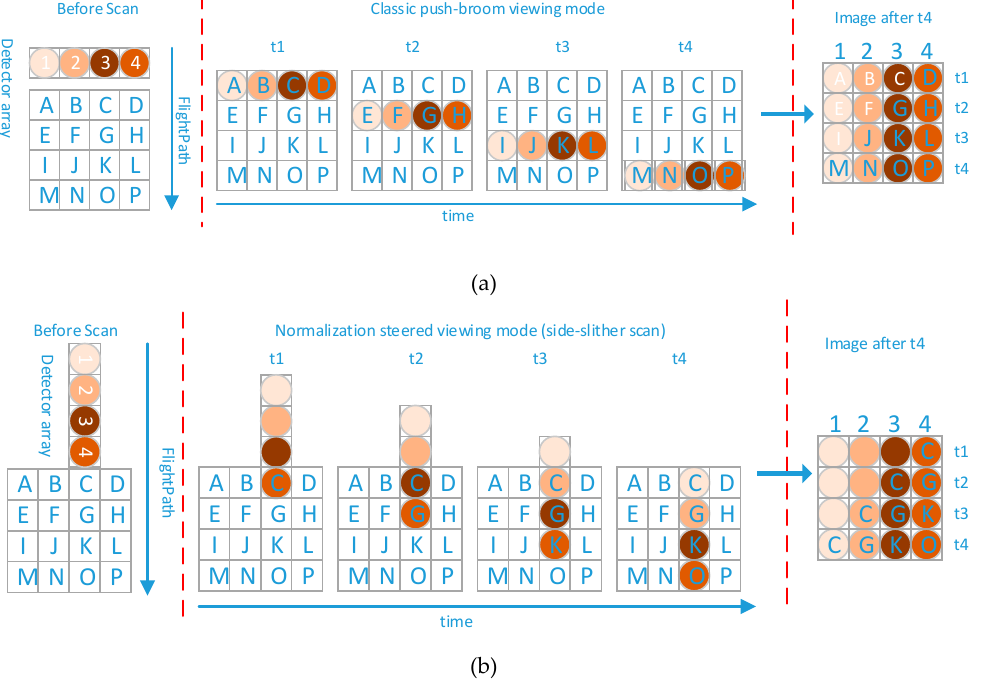
Figure 1. ( a ) Classic push-broom viewing mode; ( b ) Normalization steered viewing mode, also be 73 called side-slither scan. 74